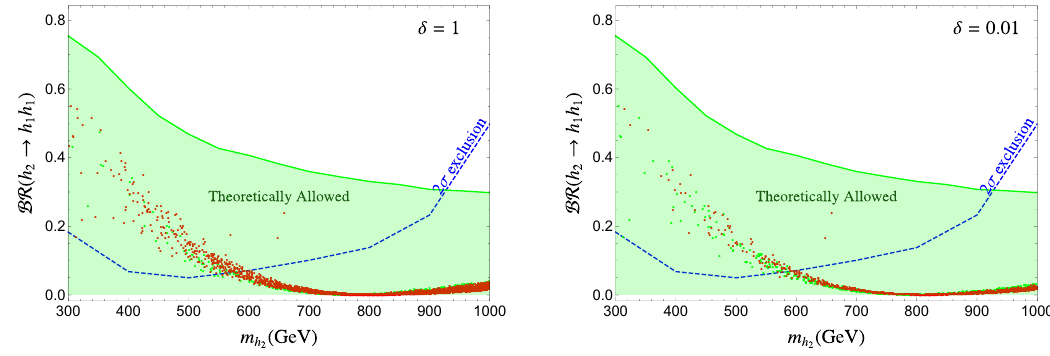
Figure 5 . 2 (cid:27) exclusion bound (blue dashed line) for the h 1 h 1 ) as a function of the ( h 2 BR ! heavy Higgs mass m h . We assume the Higgs mixing sin (cid:18) = 0 : 2 and consider the 13 TeV LHC with 2 = 3 ab (cid:0) 1 of data. The points where the resulting GW signal can be detected by LISA are overlaid L here, with the red color denoting those giving SNR > 50, and green giving 10 < SNR < 50. The left and right panels di(cid:11)er in that the points in the right panels used a reduction factor of (cid:14) = 0 : 01 in calculating the GW spectra while those in the left panel is obtained without this factor, i.e., (cid:14) = 1. Theoretical requirements on the potential such as the perturbative unitarity, perturbativity, and vacuum stability at zero temperature generally impose an upper bound on the branching ratio, corresponding to the green-colored